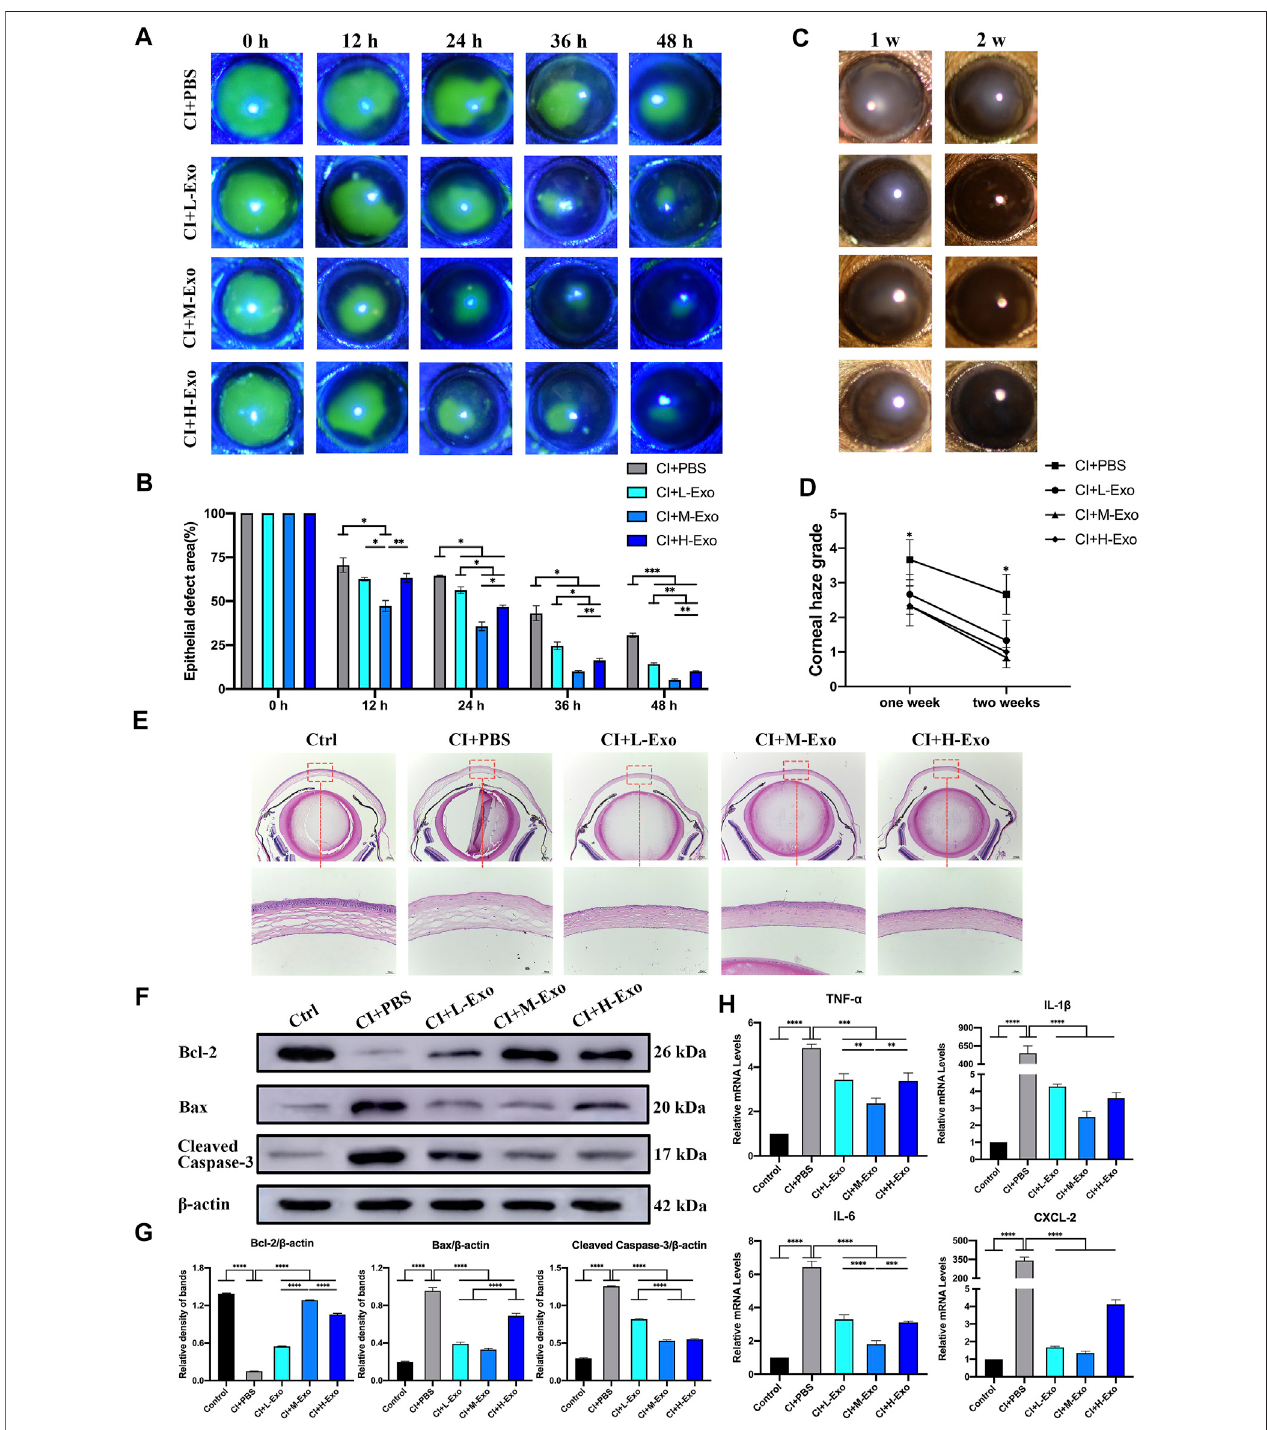
FIGURE 5 | Effect of hucMSC-Exos on CI mouse corneas. (A,B) Cornea fl uorescein staining; representative images of the corneal epithelial defect areas. Data are quanti fi ed in the bar graph. (C,D) Slit lamp showing the representative images of corneal haze. Haze grading data are quanti fi ed in line chart. (E) Mouse eyeballs were harvested at 48 h post-injury. HE staining for histologic structure of cornea wound healing. Scale bar: 250 and 50 μ m. (F,G) Western blotting showing the apoptosis related proteins Bcl-2, Bax, and cleaved Caspase-3. Relative band densities are quanti fi ed in bar graphs. (H) Quantitative PCR results for mRNA levels of the in fl ammatory cytokines TNF- α ,IL-1 β ,IL-6, and CXCL-2, and quanti fi ed inbar graphs.Dataare shown asmean±SD. *p < 0.05, **p < 0.01, ***p < 0.001,****p < 0.0001. (Control: normal corneas treated with PBS, CI + PBS: injured corneas treated with PBS, CI + L-Exo: injured corneas treated with 1 × 10 5 / μ l hucMSC-Exos, CI + M-Exo: injured corneas treated with 1 × 10 6 / μ l hucMSC-Exos, CI + H-Exo: injured corneas treated with 1 × 10 7 / μ l hucMSC-Exos).